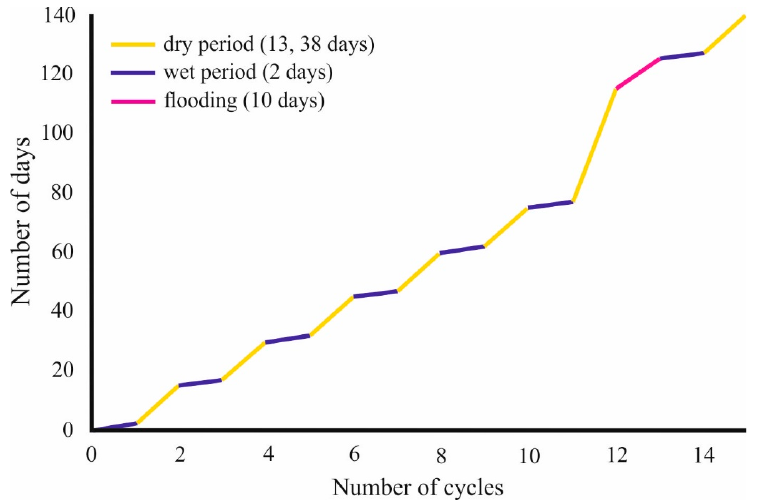
Figure 3. Geochemical modeling for 14 cycles from 38 cycles·year − 1 , the cycles contain a dry period (yellow line), wet period (blue line) and flooding (rose line).